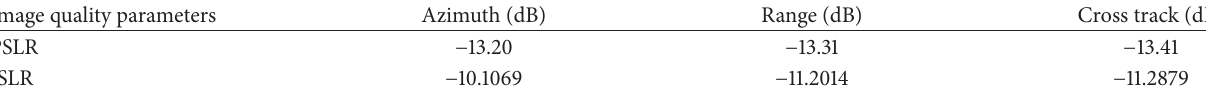
Table 3: The image quality parameters of the selected point target.